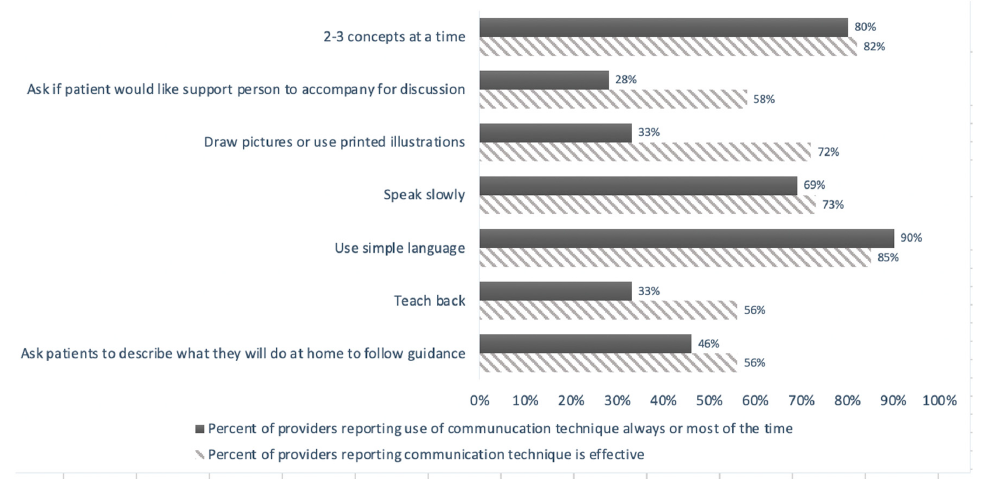
Figure 2. Use and effectiveness of American Medical Association’s 7 basic communication techniques in practice ( n = 40). Assessment of provider use and perceived effectiveness of AMA’s 7 basic communication techniques; see Rozier et al., 2011, for previous assessment of these techniques in practice by oral health providers.